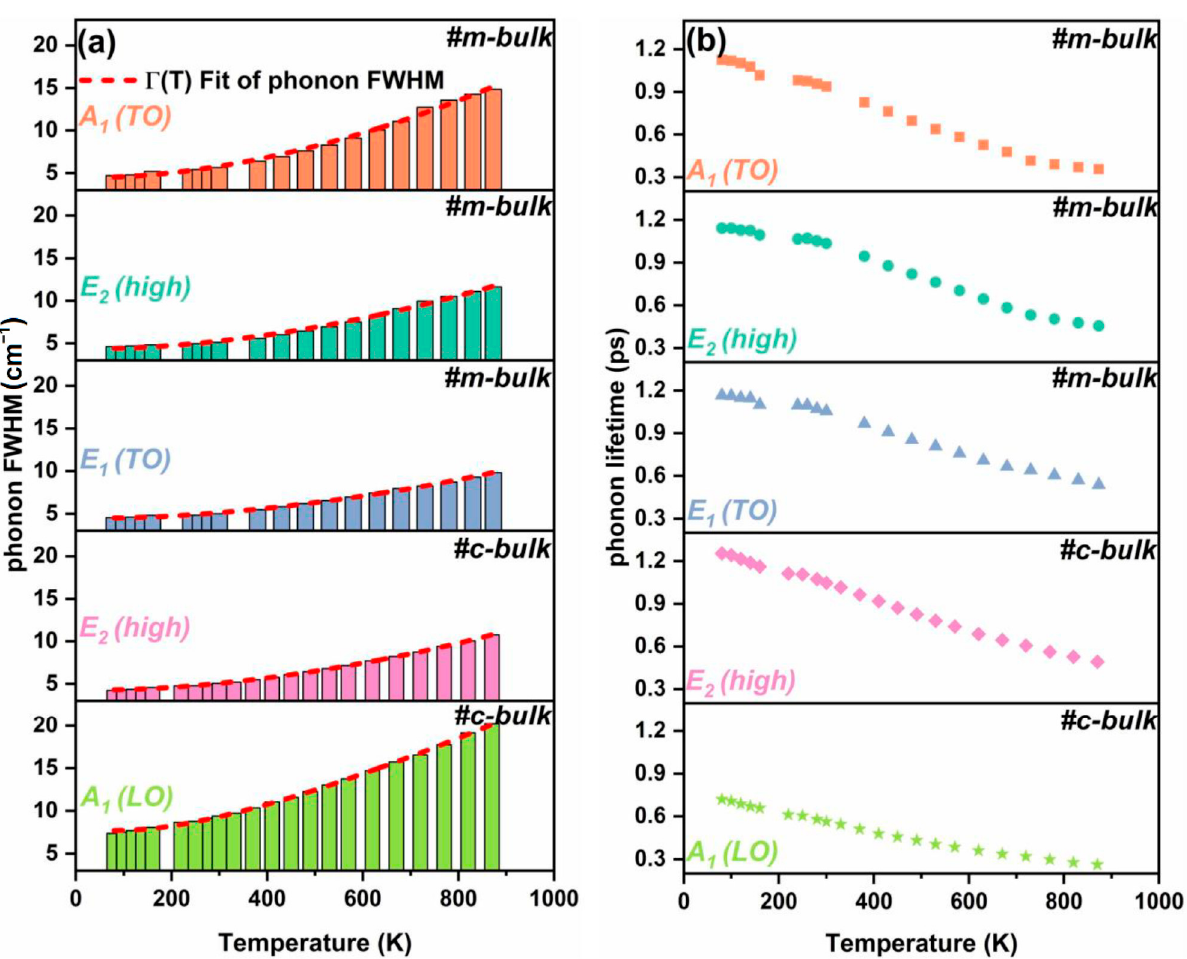
Figure 6. Phonon FWHM ( a ) and phonon lifetime ( b ) of m-bulk and c-bulk samples as a function of temperature.